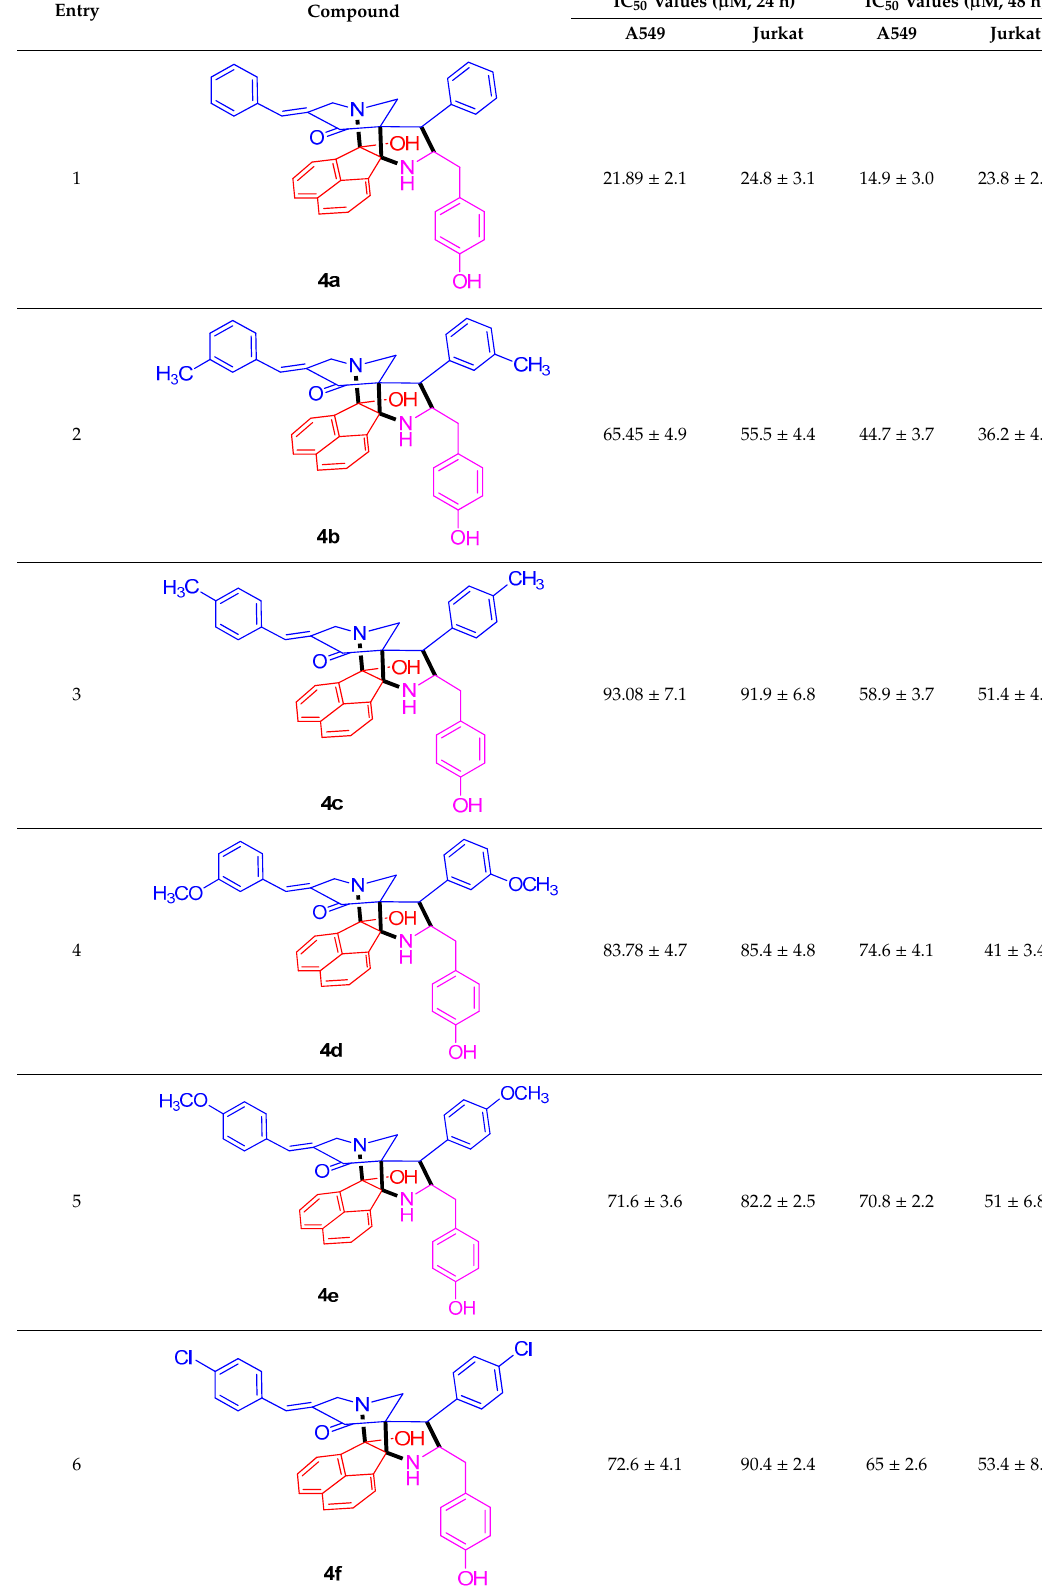
Molecules 2019 , 24 , 3820 Table 1. Comparison of the IC 50 concentrations for compounds 4 ( a – k ) against A549 and Jurkat cells. Table 1. Comparison of the IC 50 concentrations for compounds 4 ( a – k ) against A549 and Jurkat cells. Table 1. Comparison of the IC 50 concentrations for compounds 4 ( a – k ) against A549 and Jurkat cells. Table 1. Comparison of the IC 50 concentrations for compounds 4 ( a – k ) against A549 and Jurkat cells. Table 1. Comparison of the IC 50 concentrations for compounds 4 ( a – k ) against A549 and Jurkat cells. Table 1. Comparison of the IC 50 concentrations for compounds 4 ( a – k ) against A549 and Jurkat cells. Entry Entry Entry Entry Entry